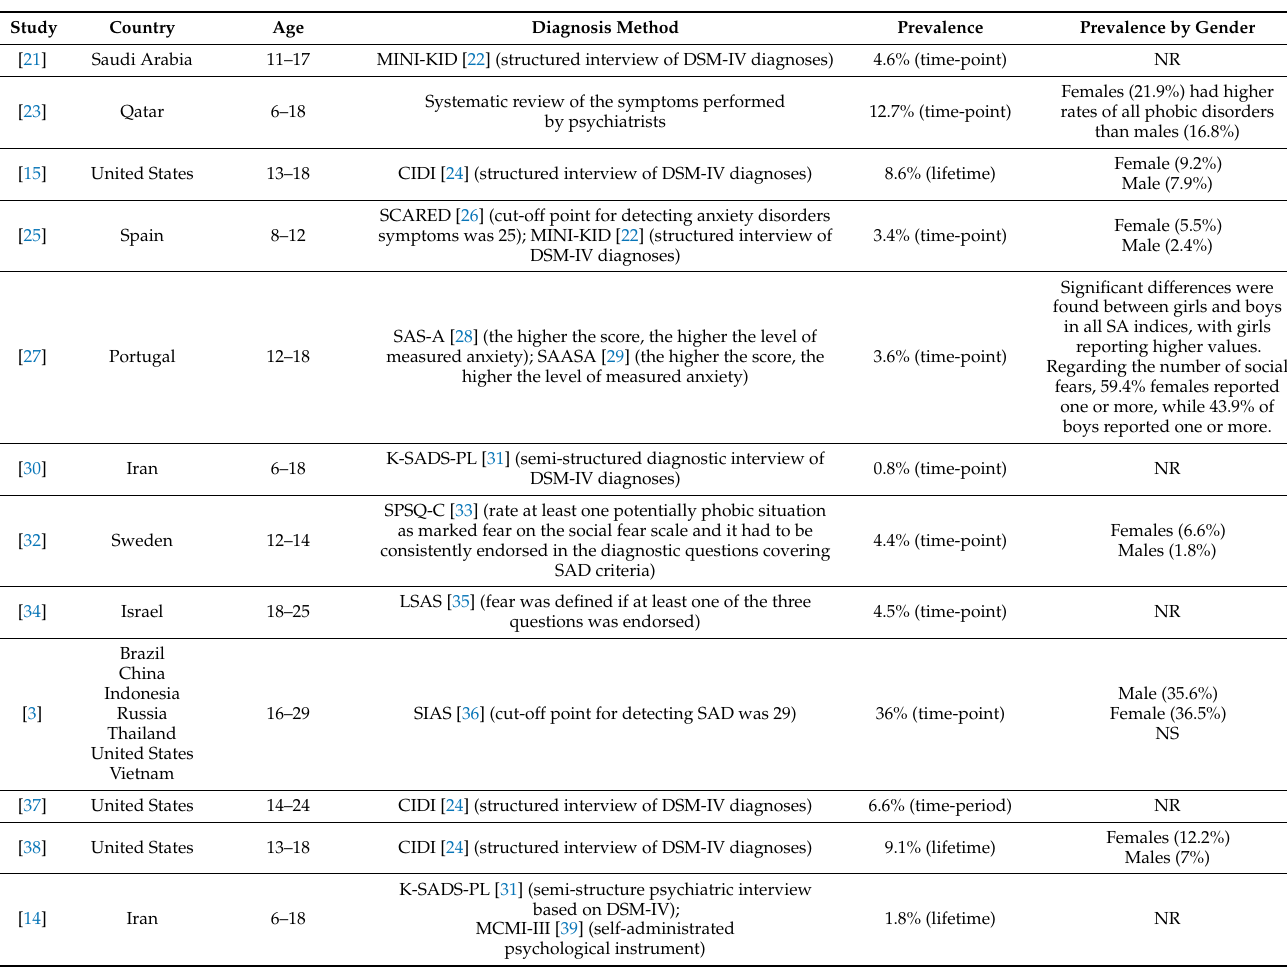
Table 1. SAD prevalence estimates from existing